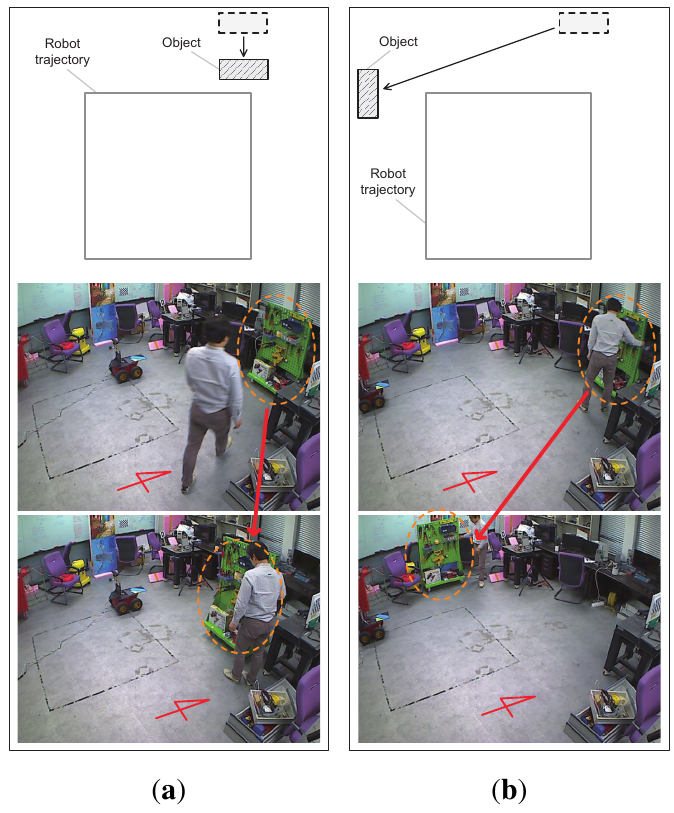
Figure 17. Relocations of the tool cart during two experiments that produce low dynamic environments. ( a ) Experiment 1; ( b ) Experiment 2.